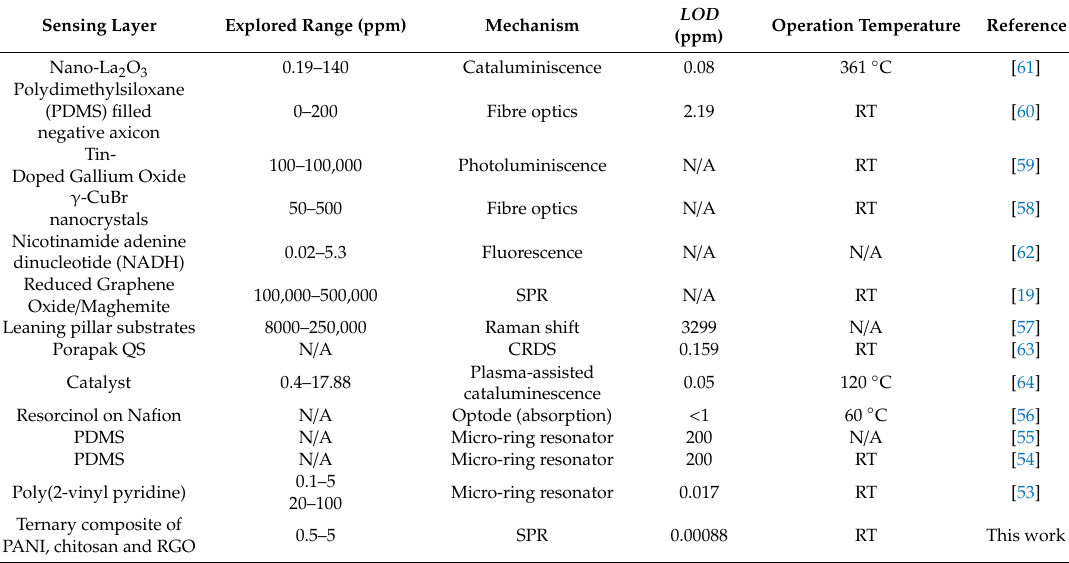
Table 4. Summary of published works on optical acetone vapour sensing and comparison with the proposed ternary composite of PANI, chitosan, and the RGO-based SPR biosensor.